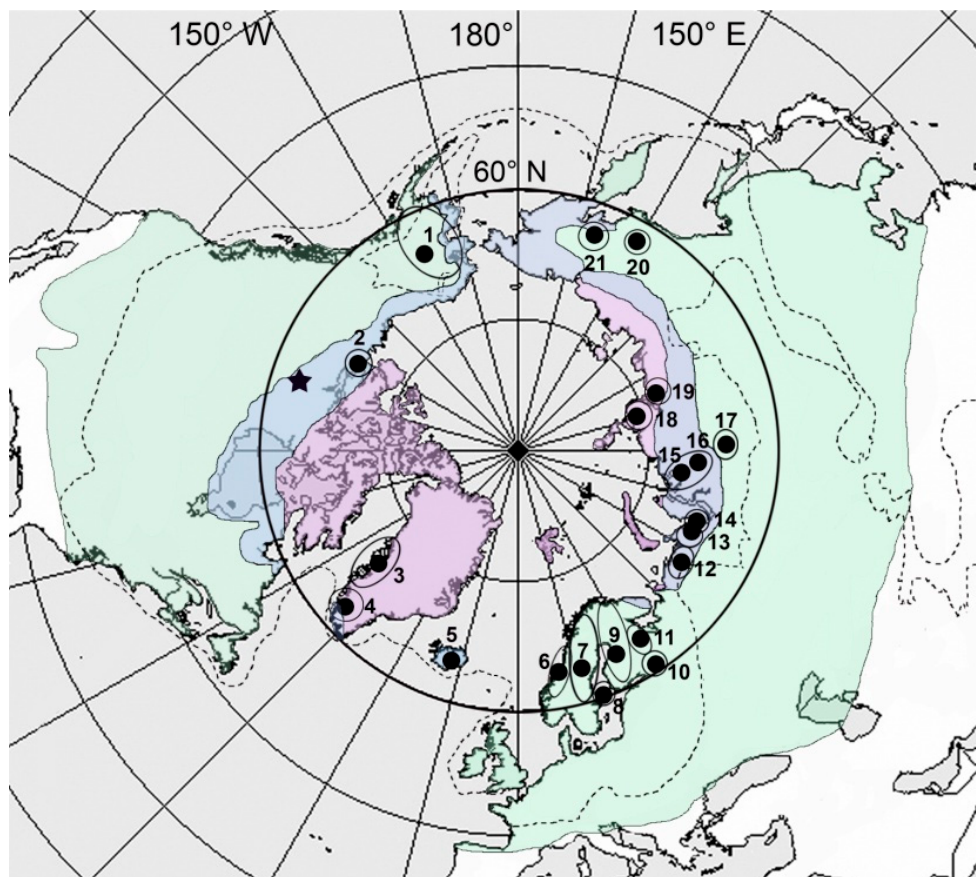
Figure 2. Map of the studied regions (numbers correspond to Table 1). Climatic zones are set up according to B.P. Alisov (1936) [48]: rose—arctic; blue—subarctic; green—temperate; solid line—Northern Polar Circle. Boundaries of the Pleistocene glaciation (dotted line) are given according to M.G. Grosswald (2009) [47]; the star shows the location of the Giraffe and Wombat kimberlite deposits [21,26]. The map was generated using the free software QGis v. 3.14.16 and edited in free image editor GIMP 2.10.0.